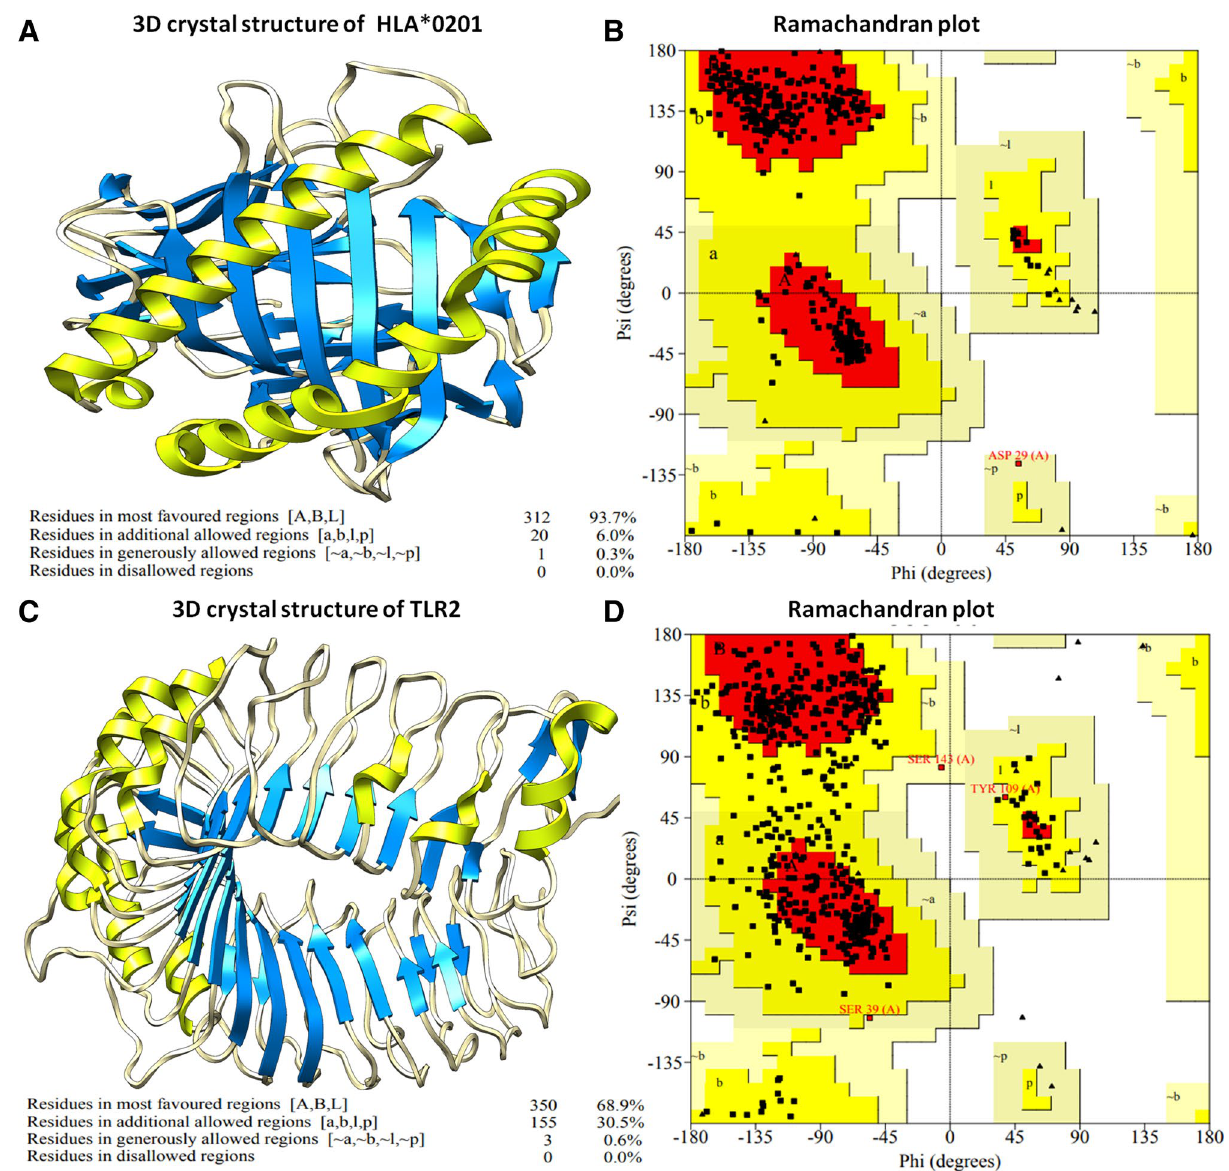
Figure 1. ( A ) Three-dimensional structure of HLA-A*0201 receptor. ( B ) Ramachandran plot analysis of HLA- A*0201 protein receptor, suggesting structure existence in the allowed region. ( C ) Three-dimensional structure of Toll-like receptor-2 receptor. ( D ) Ramachandran plot analysis of TLR2 receptor, presence in the permitted area with optimal quality of